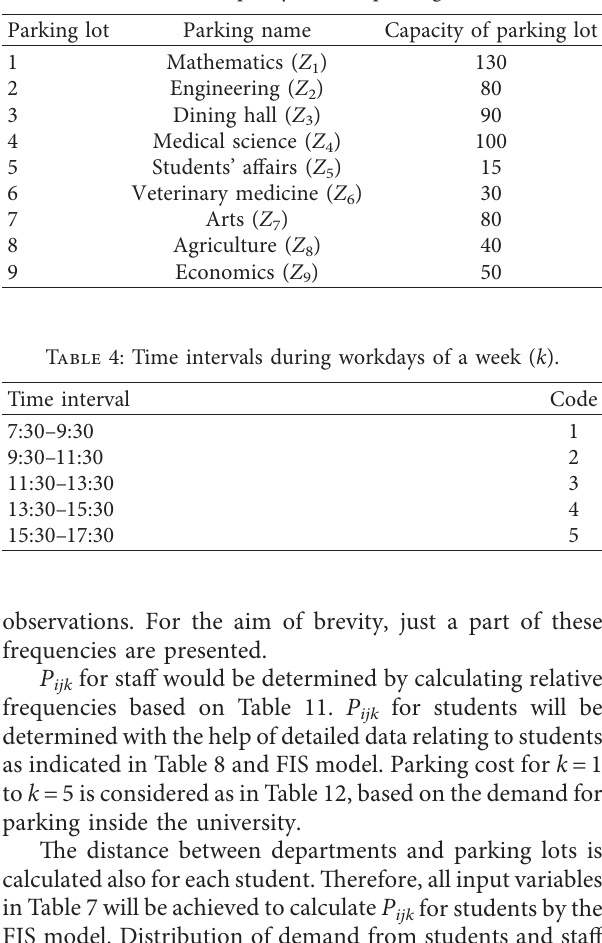
Table 3: Capacity of each parking lot.